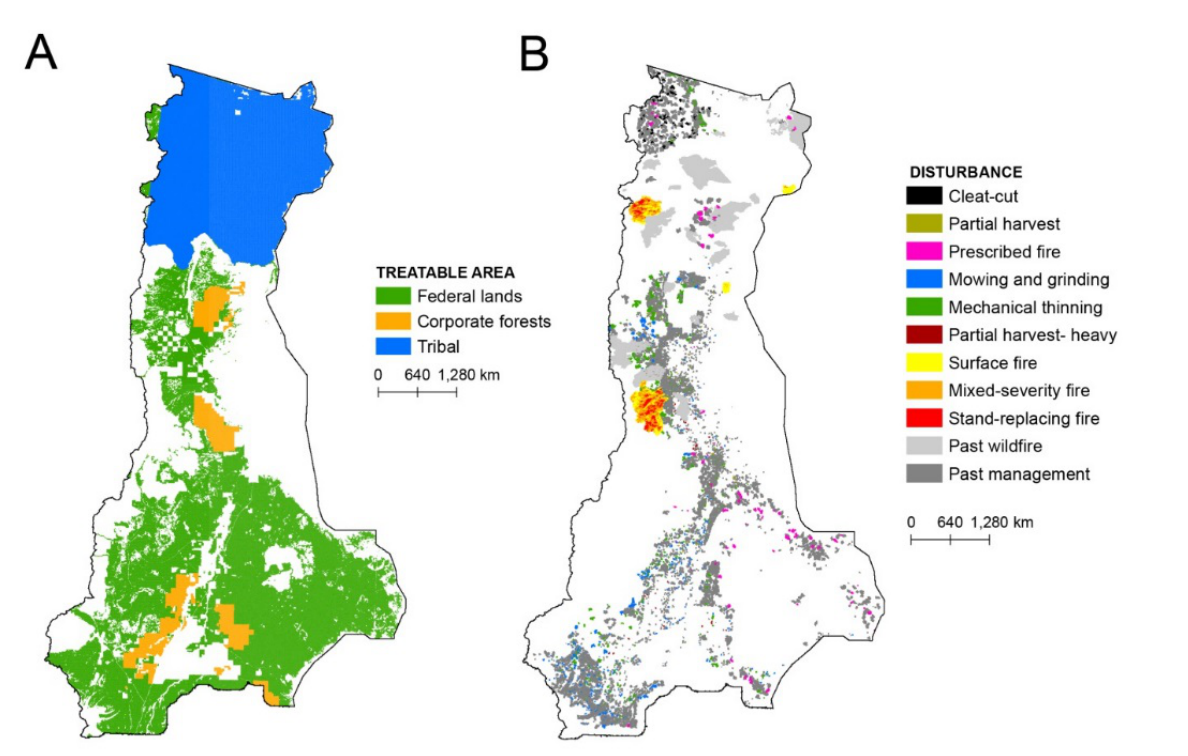
Fig. A2.1. Maps of A) treatable area and B) disturbance type (management and wildfire) at year 1 of the simulation (initial conditions) in the north sub-study area. Treatable area in federal lands corresponds to all forested lands excluding areas classified as wilderness and areas excluded from timber production due to biodiversity, conservation and amenity protection.